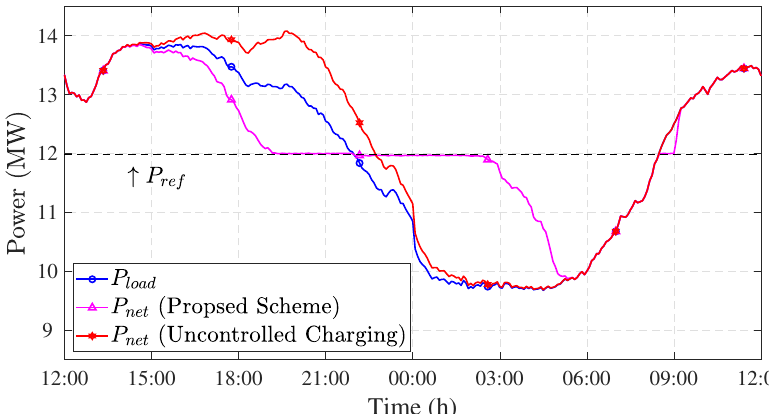
Figure 7. Net load curve of KEPCO feeder.